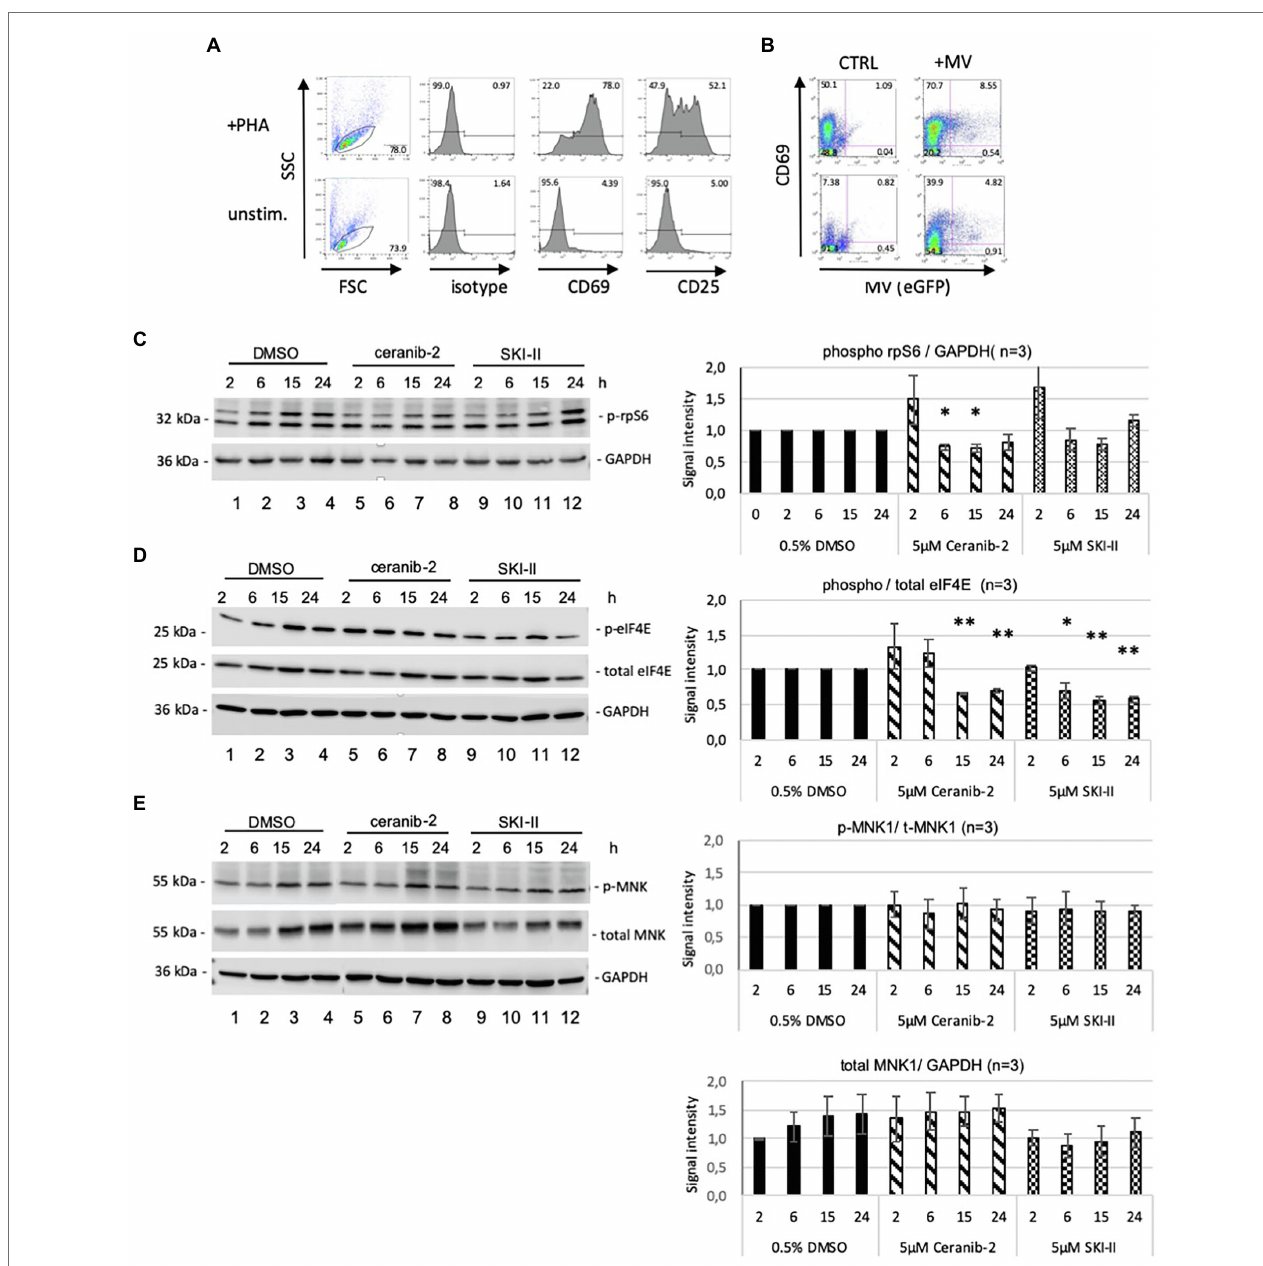
FIGURE 1 | Effects of ceranib-2 and SKI-II on rpS6, eIF4E, and MNK1 in PBL. In all experiments, the quality of the PBL after PHA (2.5 μ g/ml) stimulation was controlled by flow cytometry measuring the expression of CD69 and CD25 (A) , and the infection with MV (MV IC323eGFP) measuring the expression virally encoded GFP (B) . An example of infected and uninfected PBL in the presence and absence of PHA is shown representatively. PBL were treated for indicated times with 5 μ m ceranib-2, 5 μ m SKI-II and as control with the solvent DMSO (0.5%), and cell lysates applied to SDS-PAGE and blotted on nitrocellulose. Proteins of interest were visualized on the Western blots using appropriate antibodies and quantified. The experiments were repeated with PBL from three different donors. In (C) , Western blotting was performed to detect phosphorylated rpS6 and GAPDH. The corresponding quantification of the blot is shown on the right side ( n = 3; blots from one representative experiment are shown). The reduction of rpS6 phosphorylation by ceranib-2 at 6 and 15 h was significant in comparison with corresponding time points of control signals (with * p ≤ 0.05 calculated by student’s t -test). In (D) , Western blotting was performed to detect phosphorylated eIF4E, total eIF4E, and GAPDH. The quantification with normalization to the corresponding DMSO control values for each time point is shown on the right side. The values for phosphorylated over total eIF4E signals are given. Significances were calculated by student’s t -test by comparing corresponding time points of inhibitor treated with control signals ( n = 3; with * p ≤ 0.05 and ** p ≤ 0.01). In (E) , Western blotting was performed to detect phosphorylated MNK1, total MNK1, and GAPDH. Quantifications of the phosphorylated over total MNK1 and total MNK1 protein over GAPDH are given. Some blots were used for detection of two different proteins (MNK1 and eIF4E) and GAPDH controls were used for both. In some cases, two blots with lysates from the same experiment were used for the detection of total and phosphorylated proteins, and the corresponding GAPDH controls were used for quantification. In this case, only one representative GAPDH control is